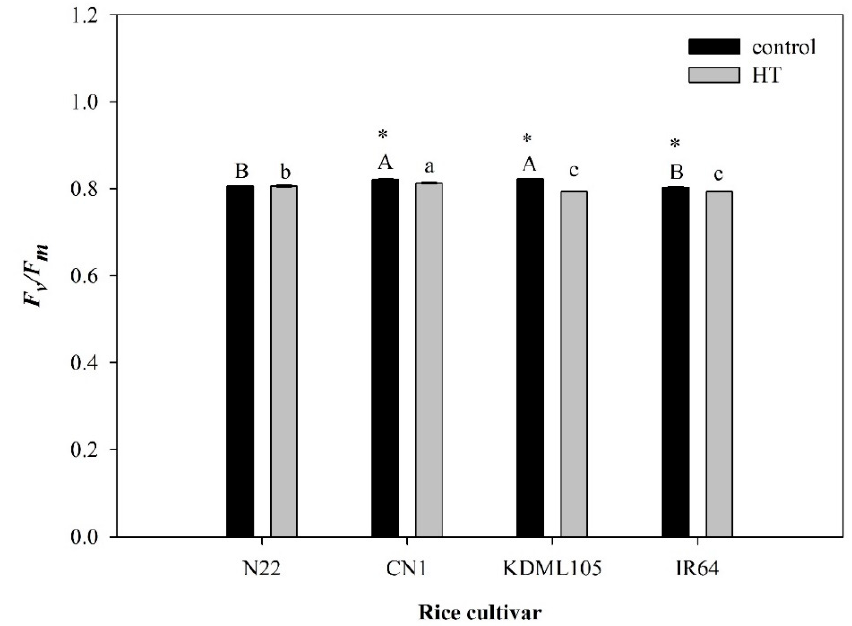
Figure 1. Effect of HT on F v /F m in four rice cultivars (N22, CN1, KDML105 and IR64). Each bar presents mean ± SE ( n = 3–4). Asterisk (*) indicates significant difference between control and HT in each rice cultivar at p ≤ 0.05 by t test. Different capital letters indicate significant difference of control group in different rice cultivars at p ≤ 0.05 by ANOVA and DMRT, and small letters indicate significant difference of HT in different rice cultivars at p ≤ 0.05 by ANOVA and DMRT.